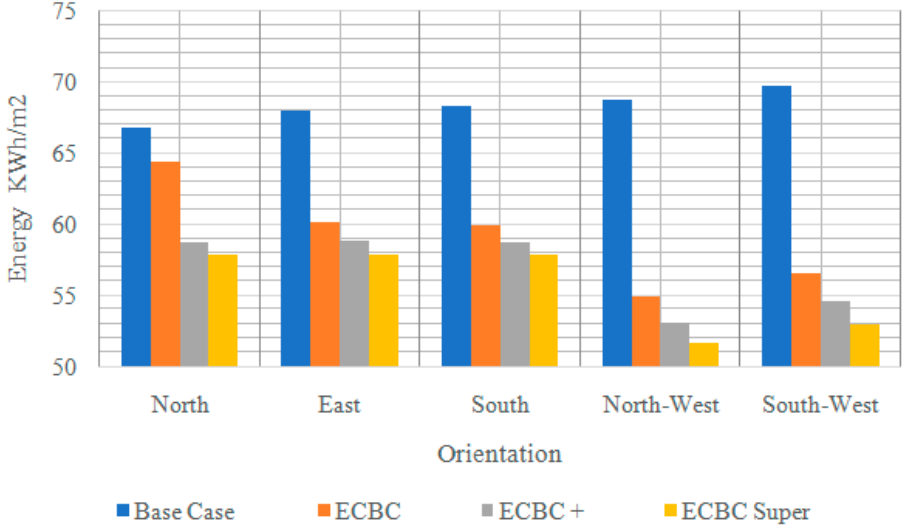
Figure 10. Annual cooling load reduction in the second-floor sample classrooms with the ECBC envelope options.